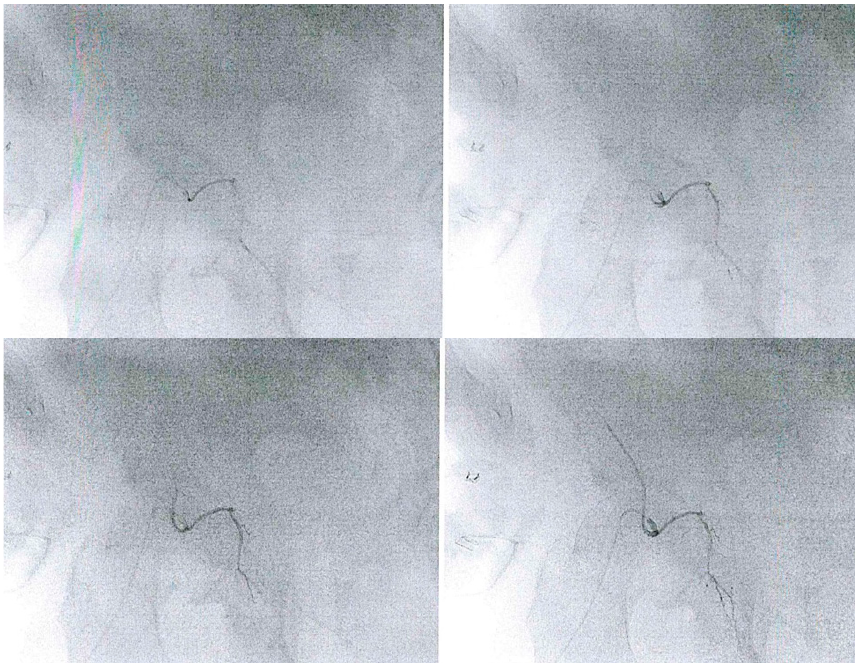
Figure 3. Superselective catheterization of the inferior right epigastric artery: the pubic branch shows a small pseudoaneurysm.